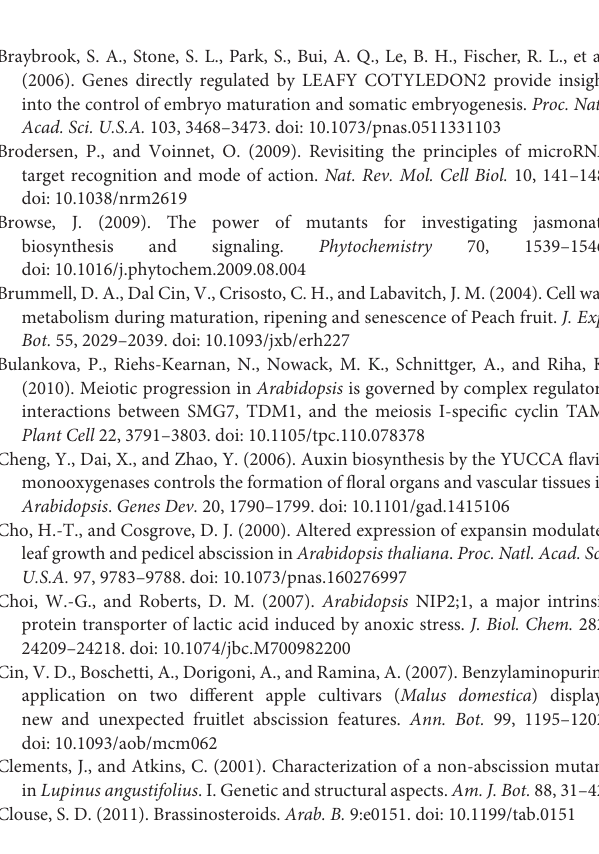
Table S1 | List of primers used for the RT-qPCR validation and the RT-qPCR validation results. Table S2 | Quality filtering and statistics of raw reads obtained for eight transcriptome libraries of L . luteus